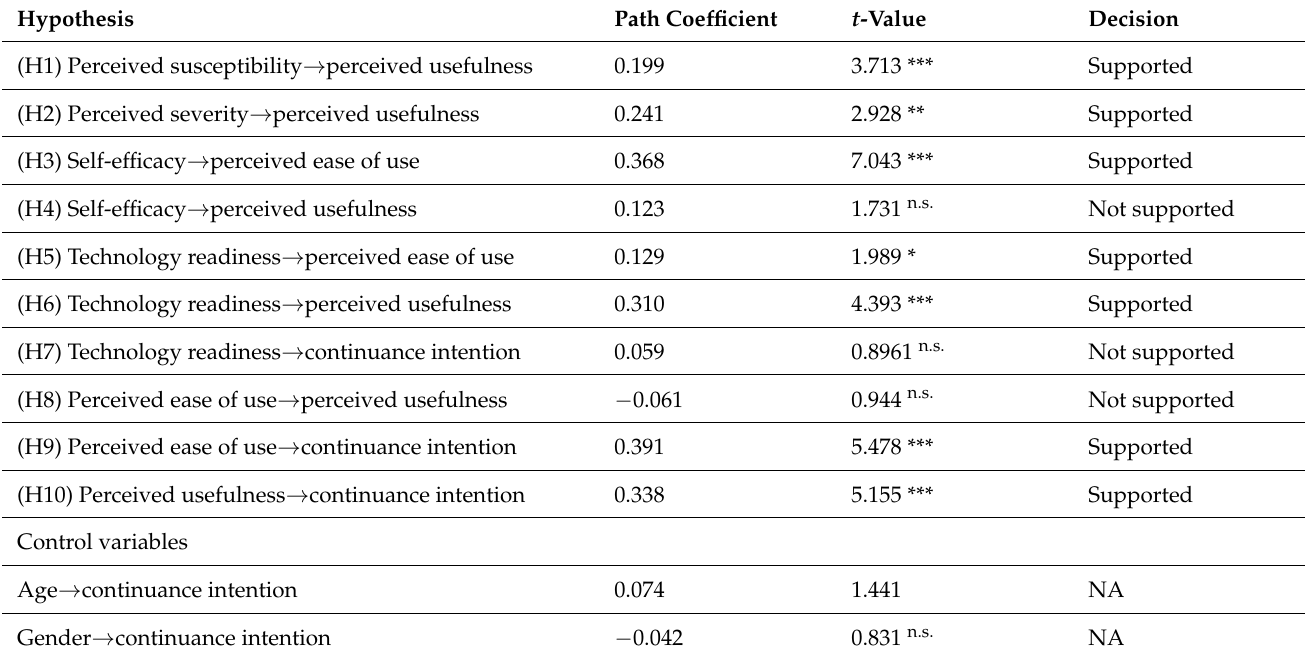
Table 4. Results of the hypothesis